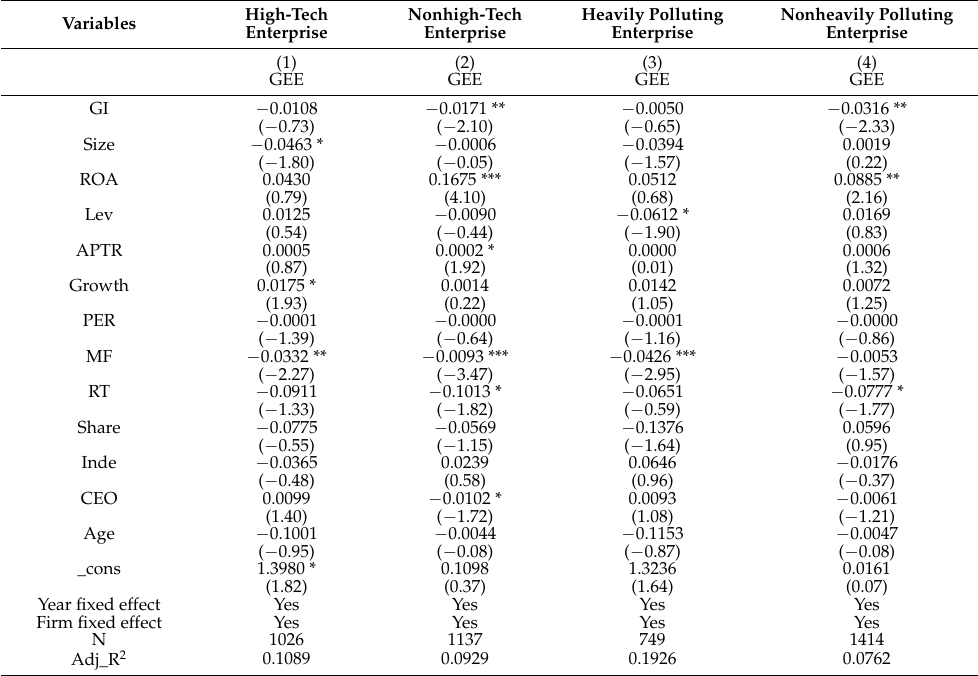
Table A14. Influence of the nature of production and operation activities of enterprises (Full version of Table 7).